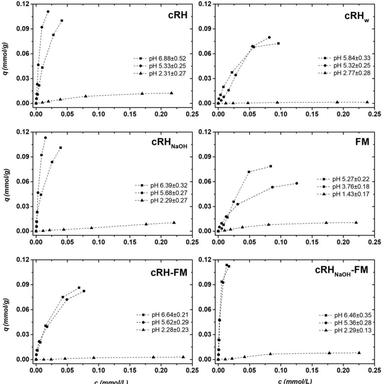
Lead adsorption isotherms of the different adsorbents at different pH values. T = 20 ◦C, adsorbent mass 20 mg, volume 10 mL, metal ion concentration between 0 and 50 mg/L (0.241 mmol/L). The ions concentration is affected by an error lower than 4 % while that of the adsorption capacity is lower than 6 %. Lines are guides for the eyes.